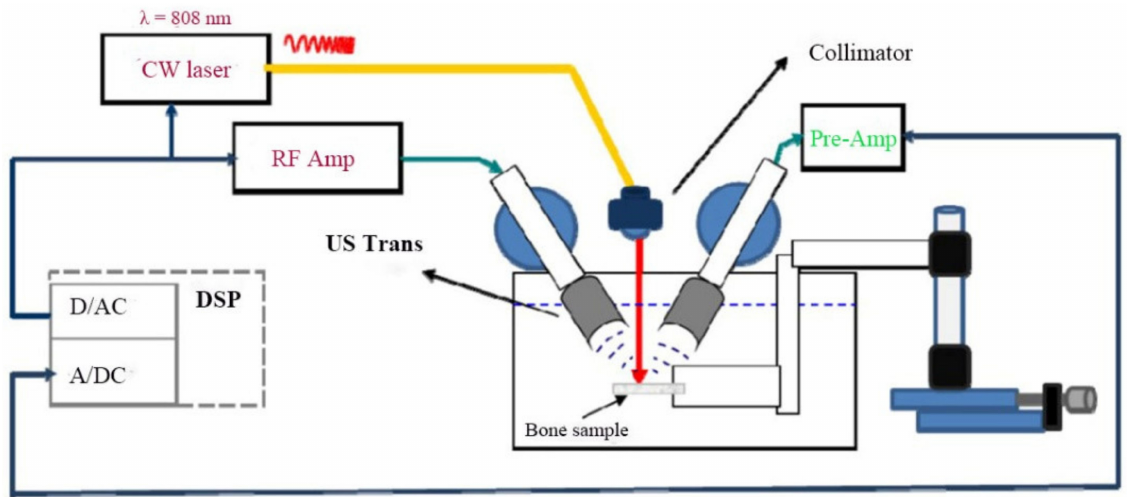
Figure 1. Schematic of the experimental